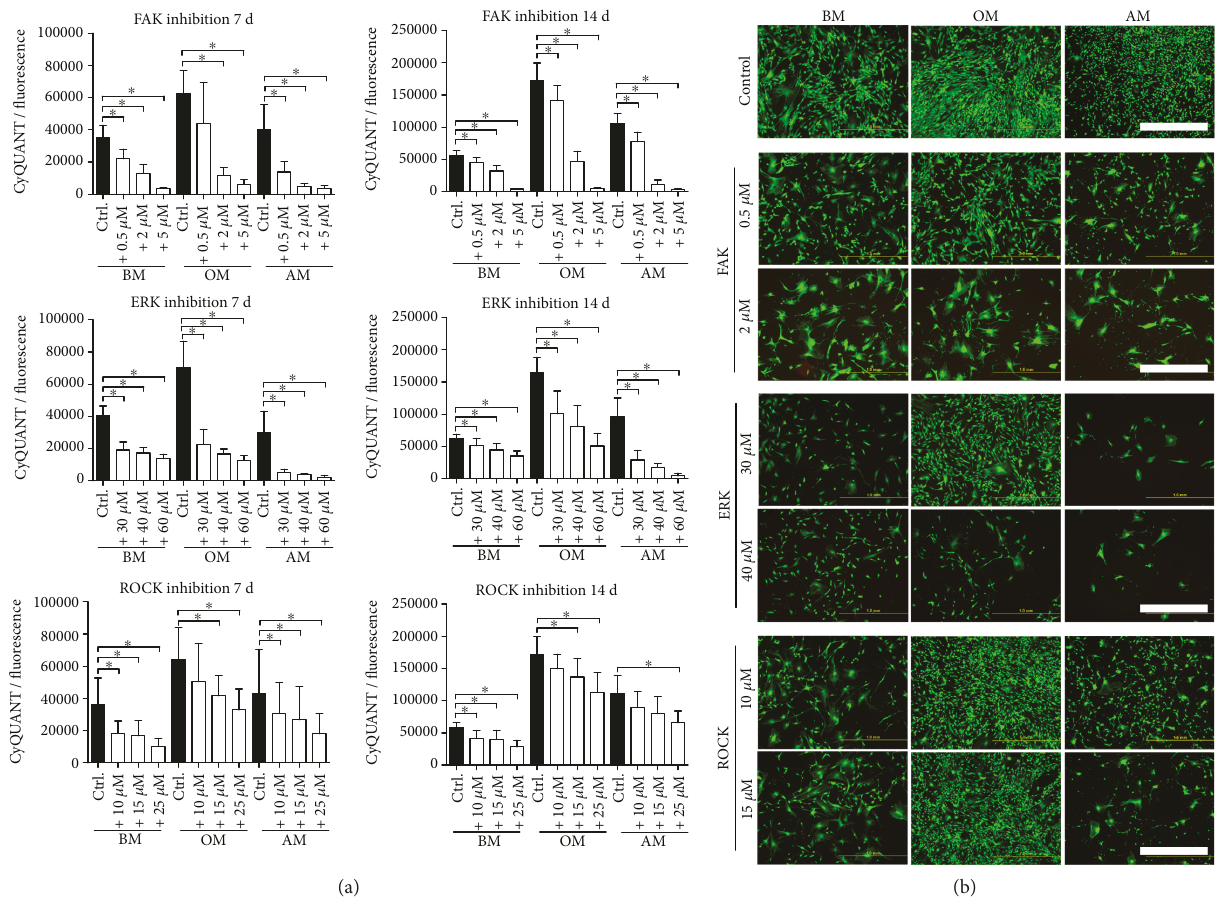
Figure 1: Cell viability and proliferation after 7 and 14 days of culture in response to inhibition of FAK, ERK1/2, and ROCK signaling. (a) hASCs were cultured 7 or 14 d in BM, OM, and AM supplemented with FAK, ERK1/2, and ROCK inhibitors. The inhibitor e ff ect on proliferation was studied in each culture condition separately by comparing the di ff erent inhibitor concentrations with the untreated medium control. Signi fi cance level 5%, designated with an asterisk ( ∗ ). FAK, ERK, and ROCK inhibitors: N = 12 (independent biological replicates from 4 donors). (b) Representative fl uorescence images of LIVE/DEAD-stained hASCs. hASCs were cultured in BM, OM, or AM supplemented with the abovementioned inhibitors. Cell viability was analyzed with LIVE/DEAD assay at 7 d. Green dye represents living cells, red dye dead cells. Scale bar 1.0mm. BM: basic medium; OM: osteogenic medium; AM: adipogenic